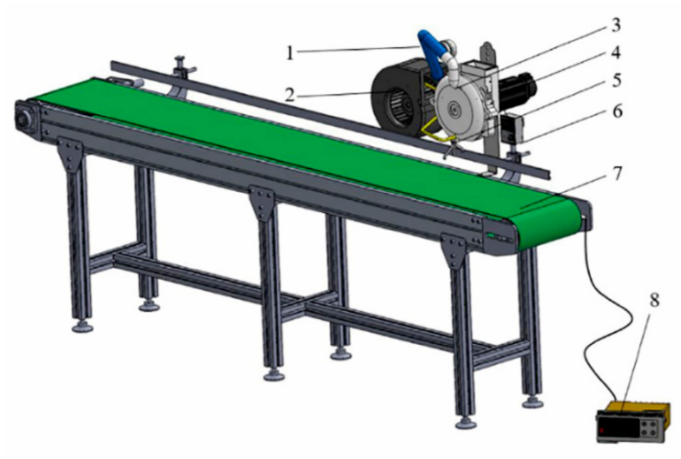
Figure 1. The experiment bench schematic diagram. 1. Vacuum tube, 2. Fan, 3. The metering device, 4. Variable frequency motor, 5. Positive pressure tube, 6. Motor governor, 7. Conveyor belt, 8. Conveyor belt frequency modulator.